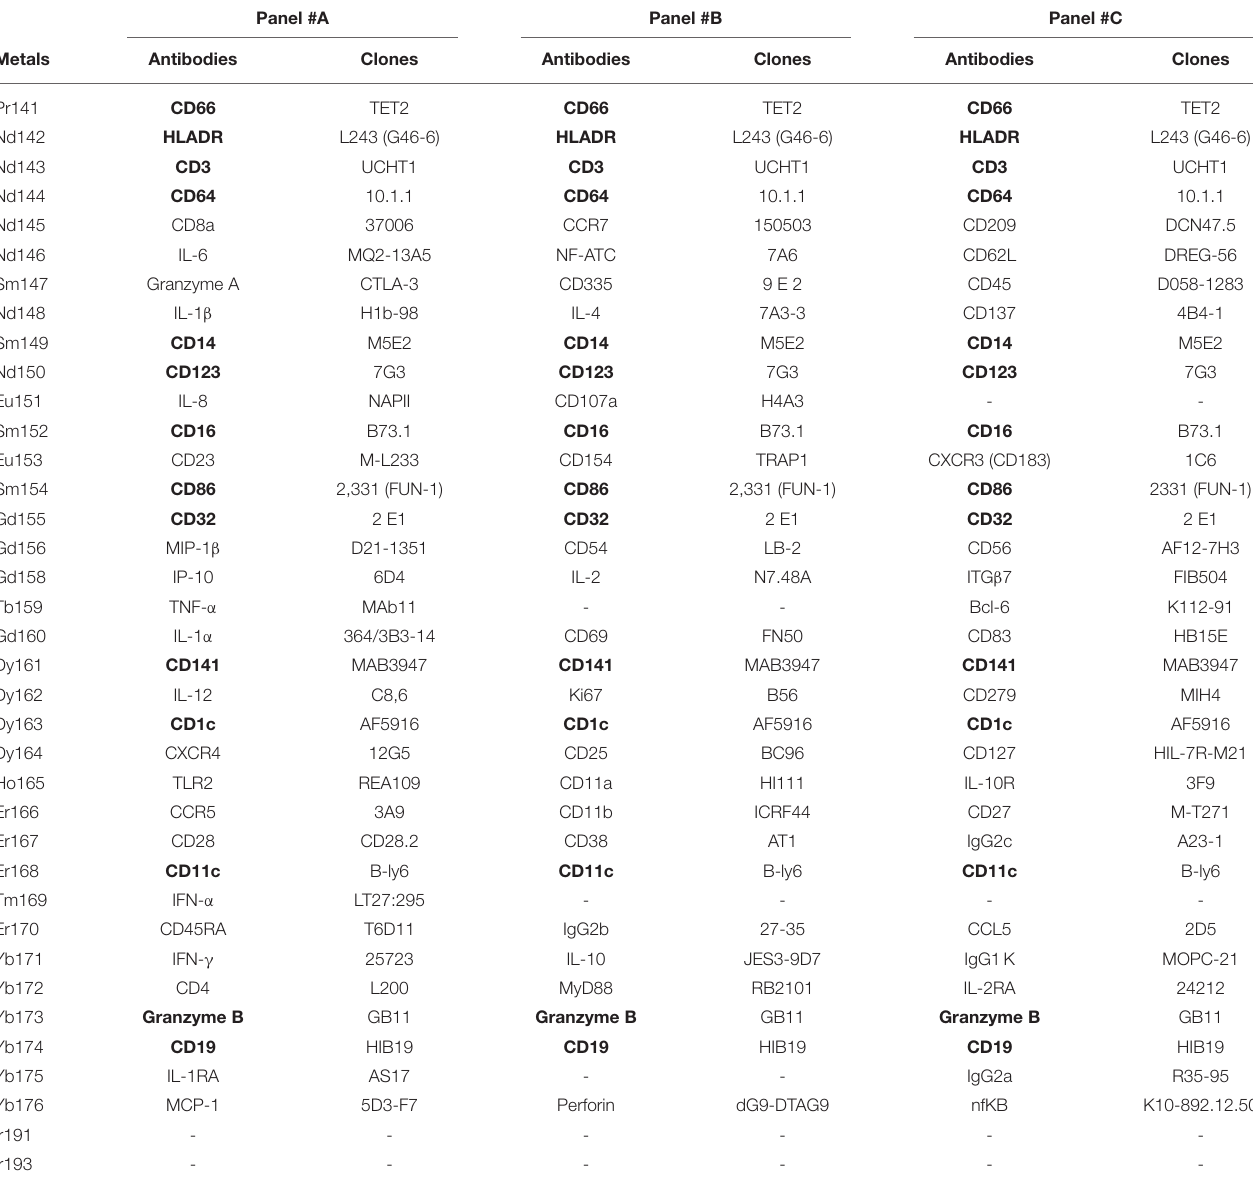
The metal isotopes, markers, and antibody clones are indicated for each panel. Backbone markers are indicated in